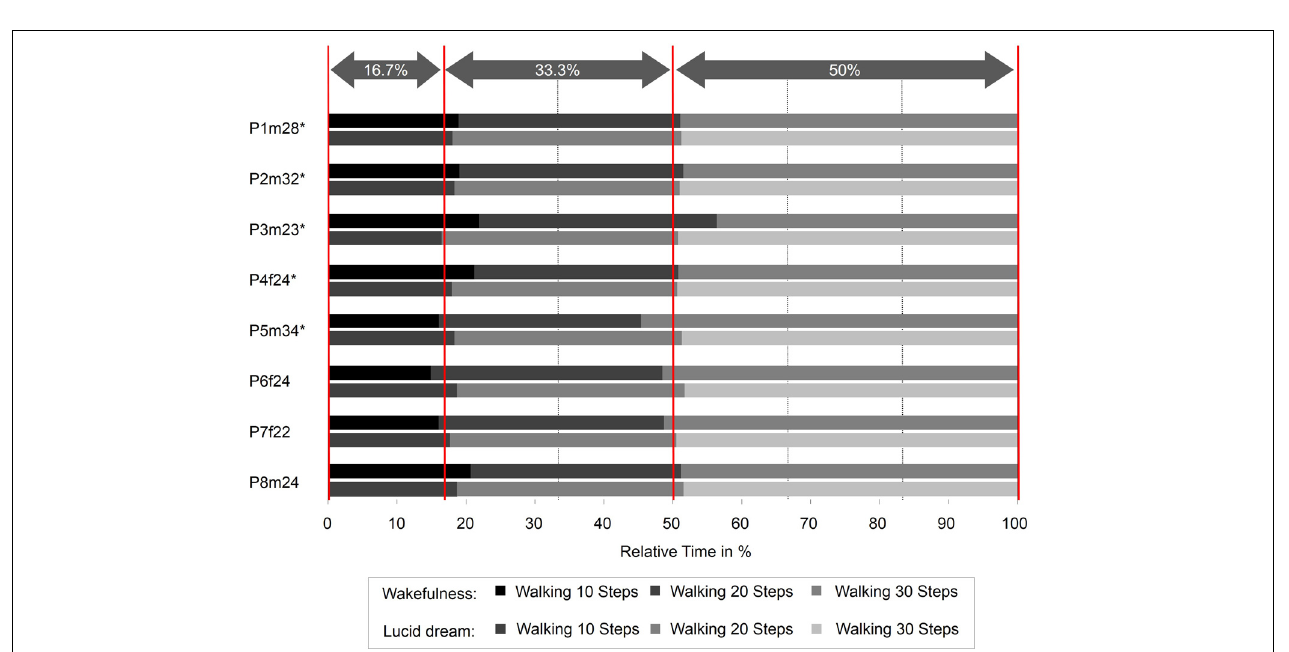
FIGURE 5 | Absolute durations for the counting task during wakefulness and lucid dreaming (Labels: e.g., P1m28 = Participant 1, male, 28 years. ∗ Participants of the counting task also completed the walking task).